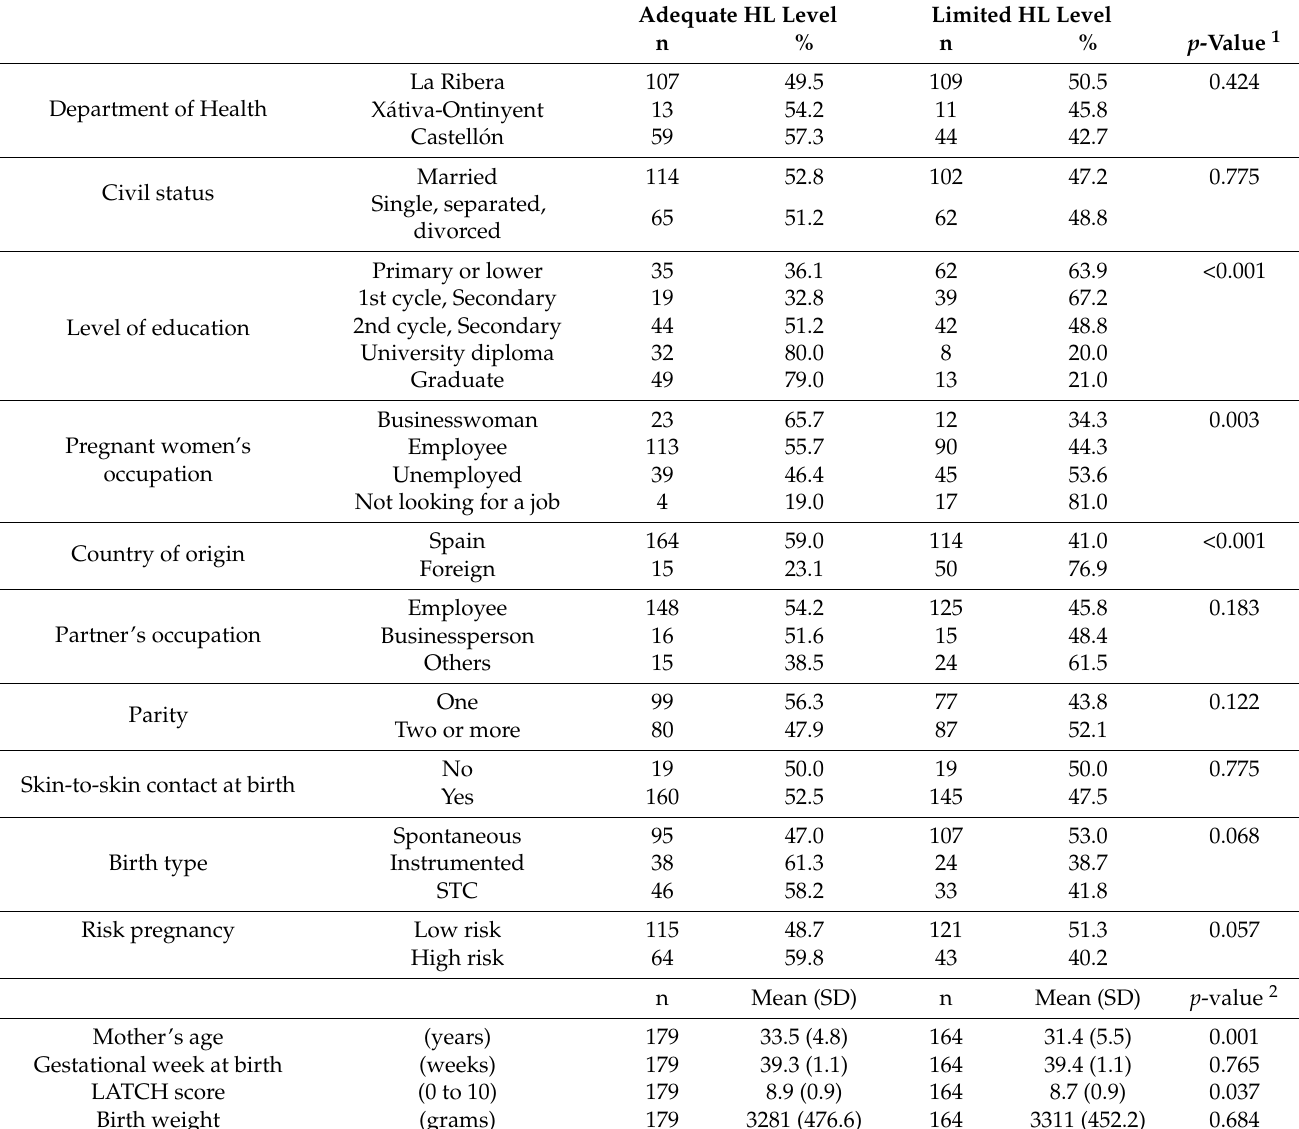
Table 2. Relation between HL levels (NVS) and the studied